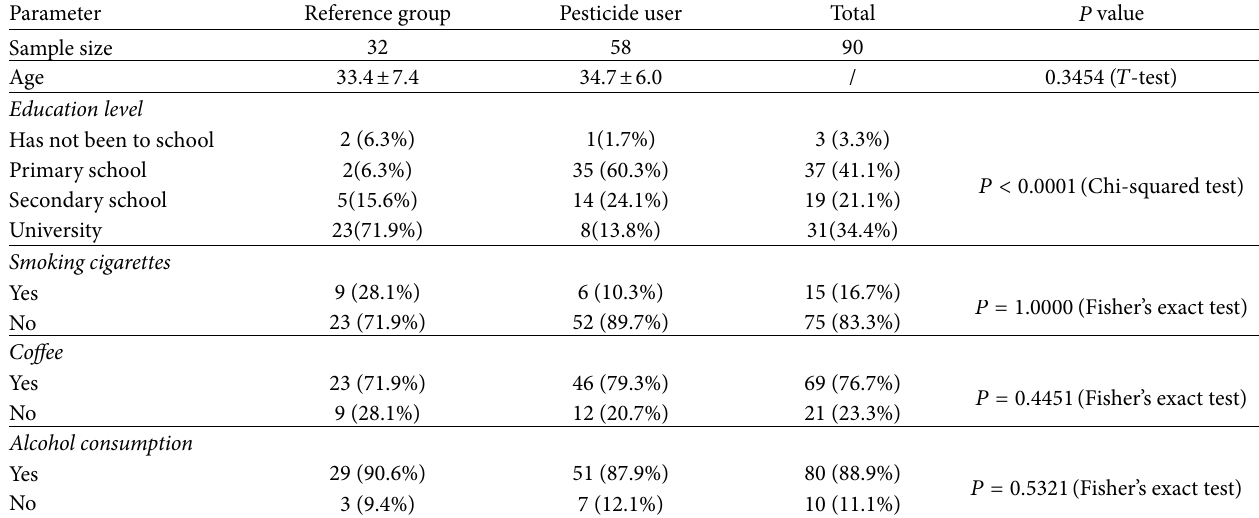
Table 1: General characteristics of the study population.